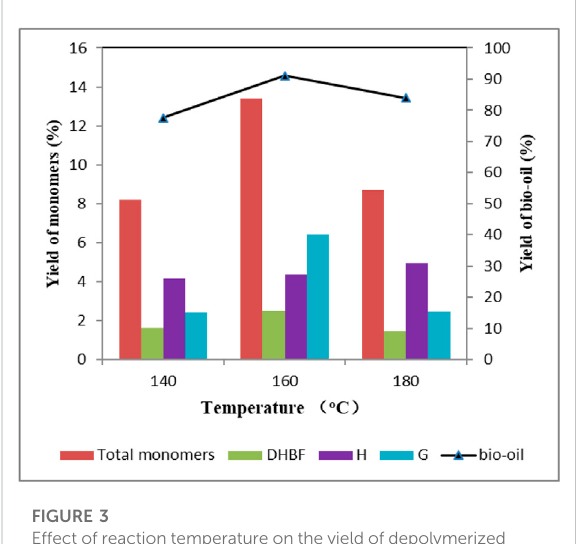
FIGURE 4 Effect of reaction time on the yield of